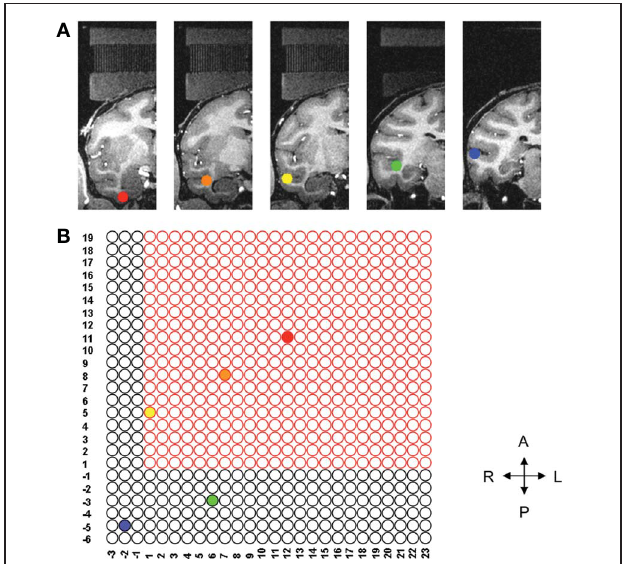
FIGURE 2 | Location of each of five ROIs and corresponding grid holes. (A) Five ROIs in the coronal plane, each of them marked by different color. (B) Illustrates the five sites needed for the study on the grid. Only the three sites inside the bounded box can be reached using the conventional straight grid; the remaining two sites are beyond the reach of the straight grid. The left hemisphere (not shown) also had three sites that could be reached with the straight grid and two sites out of reach of the straight grid.